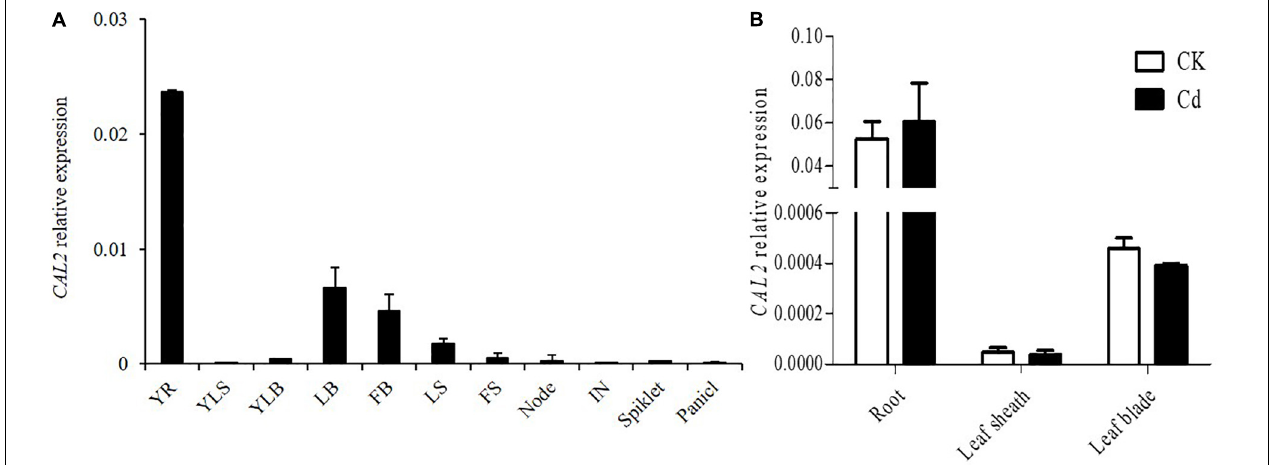
FIGURE 2 | Expression pattern of CAL2 . (A) CAL2 expression in various rice tissues. YR, young root; YLS, young leaf sheath; YLB, young leaf blade; LB, leaf blade; FB, flag leaf blade; LS, leaf sheath; FS, flag leaf sheath; IN, internode. (B) CAL2 expression in roots of 2-week-old seedlings treated with Cd at 0 or 100 µ M Cd for 6 h. Data are means ± standard deviations of three independent biological replicates and normalized to Actin1 .